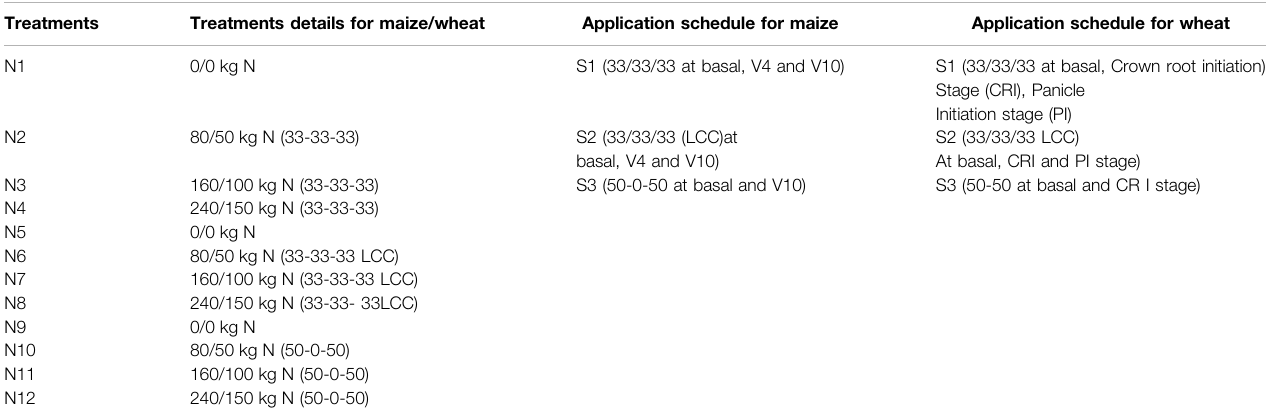
TABLE 1 | Treatments details of maize and wheat crop. Treatments Treatments details for